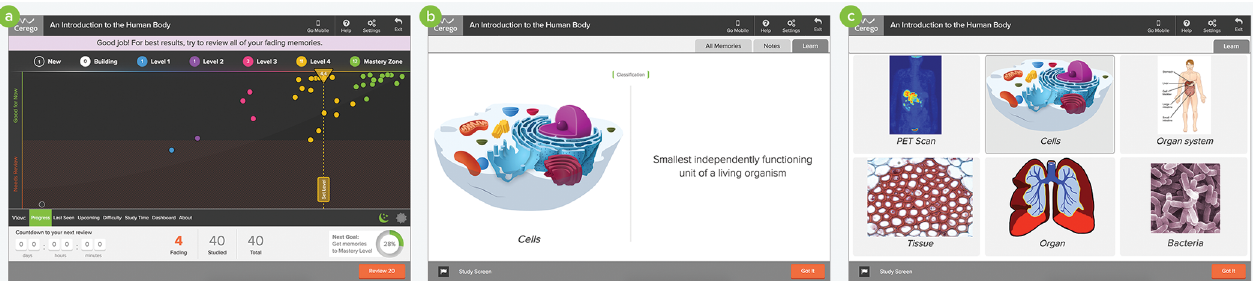
Fig 1. Example images from the website http://www.cerego.com. Examplescreens from a user’s session on Cerego. (A) When users log on, they see a visual summary of information they have learnedon Cerego.(B) Learningtrials involvepairedinformation, in this case the name and visual representation of an osteoclast pairedwith its definition.(C) On a test trial, users will be asked to either freely recall information, or select correct options from a set. In this case the user must identify the correct name and representation after having been given the definition.Printed under a CC BY license, with permission from